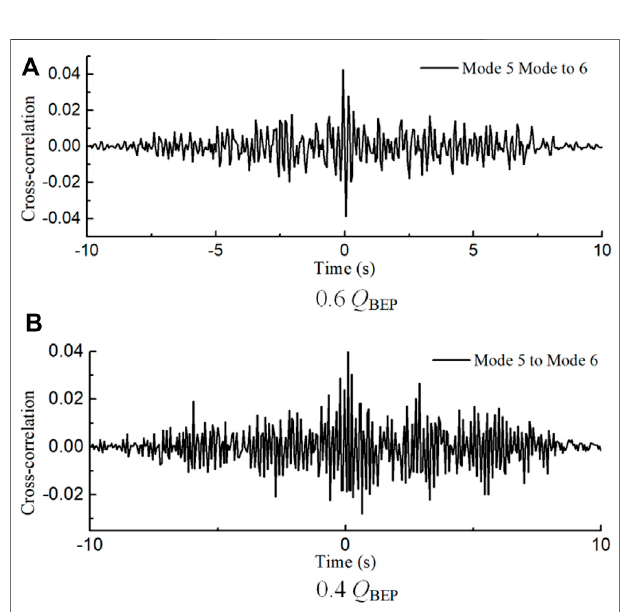
FIGURE 14 | Cross-correlation between the fi fth mode and sixth mode. (A) 0.6 Q BEP , (B) 0.4 Q BEP